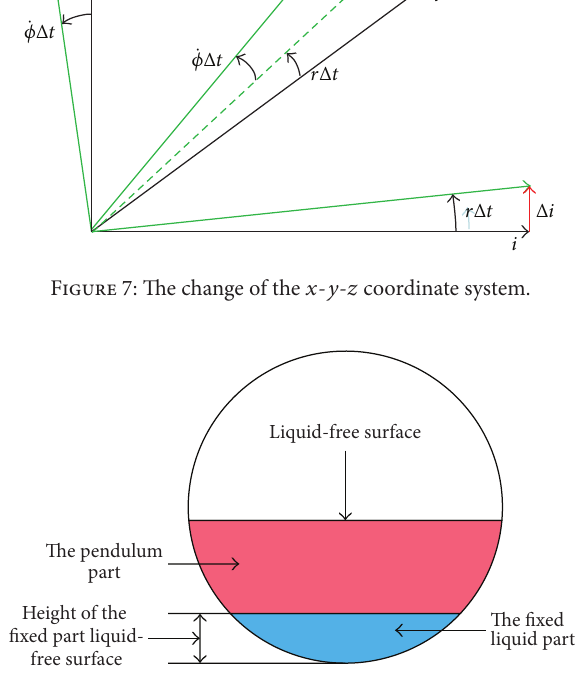
Figure 8: Schematic diagram for the division into the pendulum part and the fixed liquid